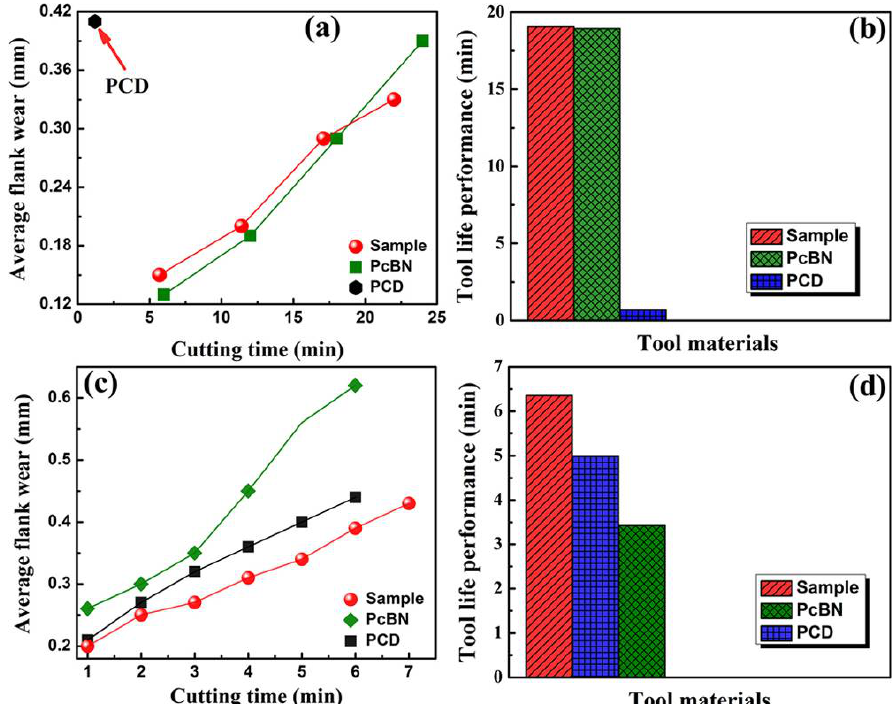
Figure 9. The cutting performance of diamond–cBN alloy compared to commercial PcBN and PCD. ( a ) and ( c ) Average flank wear versus time (min) for diamond–cBN alloy, PCD, and PcBN tools during dry cutting of hardened steel and granite. ( b ) and ( d ) Tool life performance for diamond–cBN alloy, PCD, and PcBN tools during dry cutting of hardened steel and granite. Reproduced from Wang et al. “Diamond-cBN alloy: A universal cutting material.” Appl. Phys. Lett. 107, 101901 (2015), with the permission of AIP Publishing.